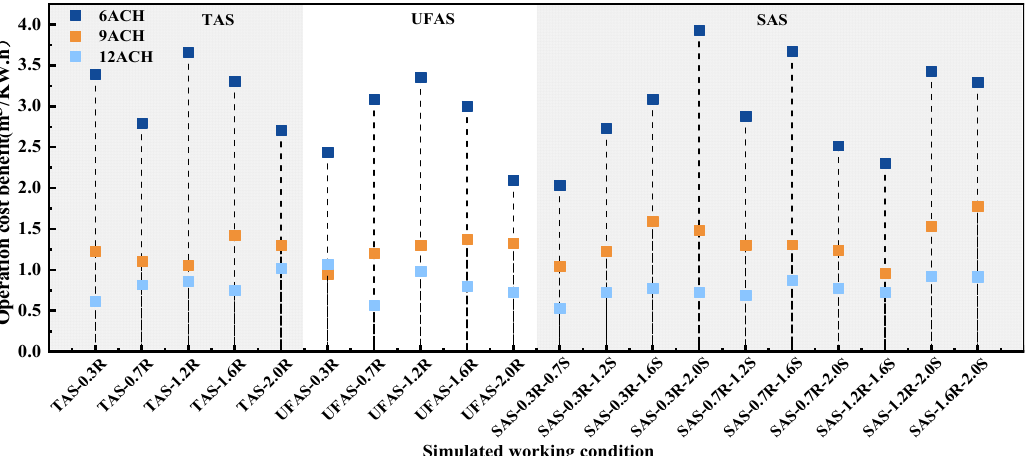
Figure 10. Operating cost-effectiveness of 60 simulated conditions.